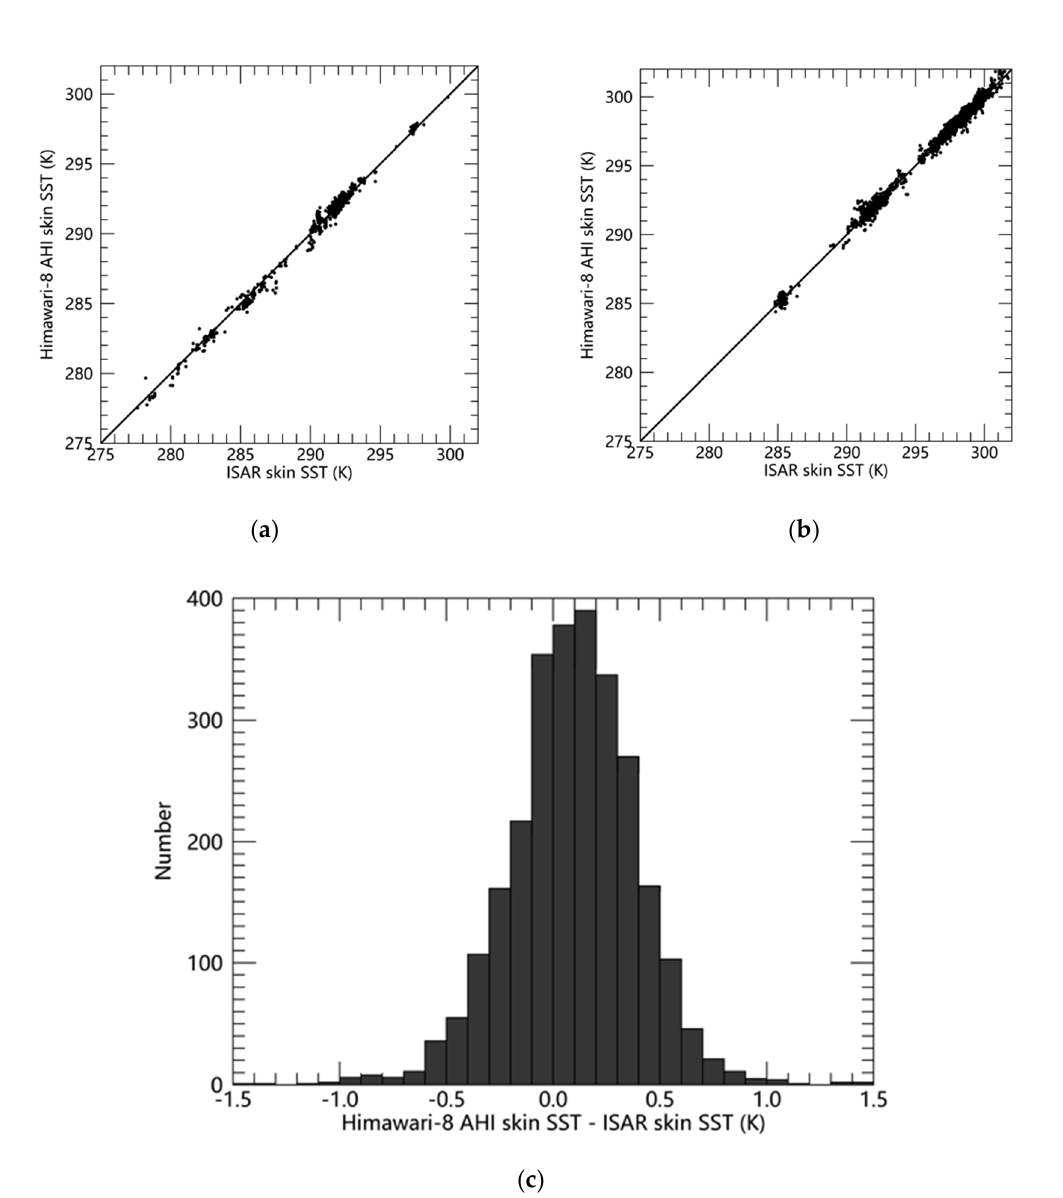
Figure 2. ( a ) ISAR QL ≤ 3 matchups with both Himawari-8 AHI skin SST and ISAR skin SST measurements; ( b ) ISAR QL ≥ 4 matchups with both Himawari-8 AHI skin SST and ISAR skin SST measurements; ( c ) histogram of the differences between Himawari-8 AHI skin SST and ISAR skin SST measurements with ISAR QL ≥ 4.